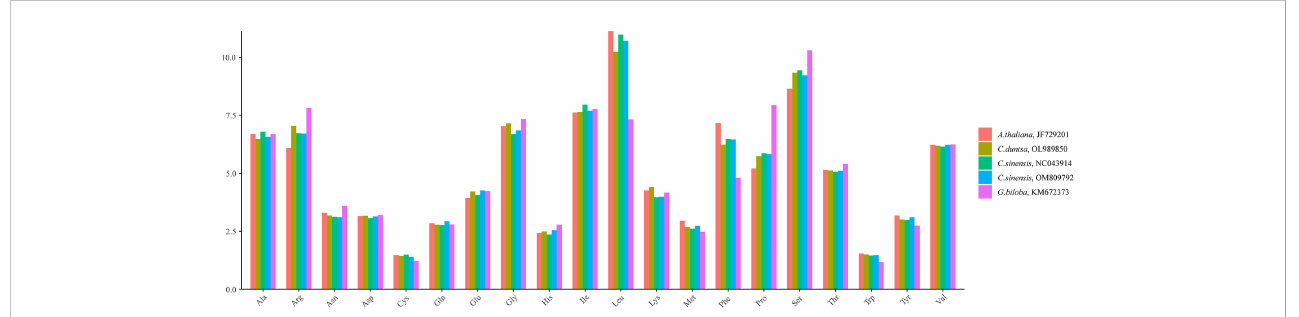
FIGURE 2 C .duntsa mitochondrial codon usage pattern compared to C.sinensis (NC043914), C.sinensis (OM809792), A.thaliana (JF729201),and G.biloba